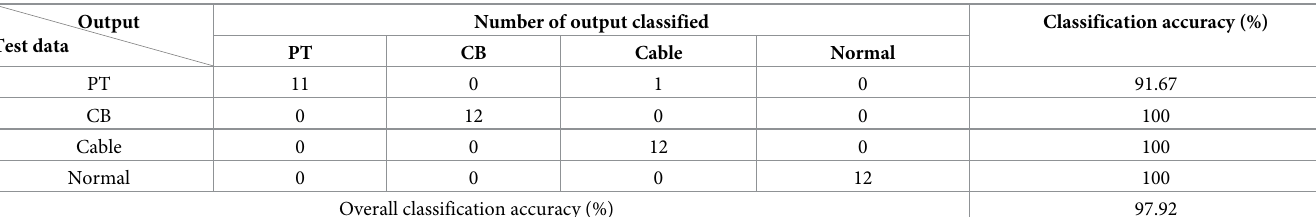
Table 6. Classification results using GSA-ANN based on 70:30 ratio for training and testing